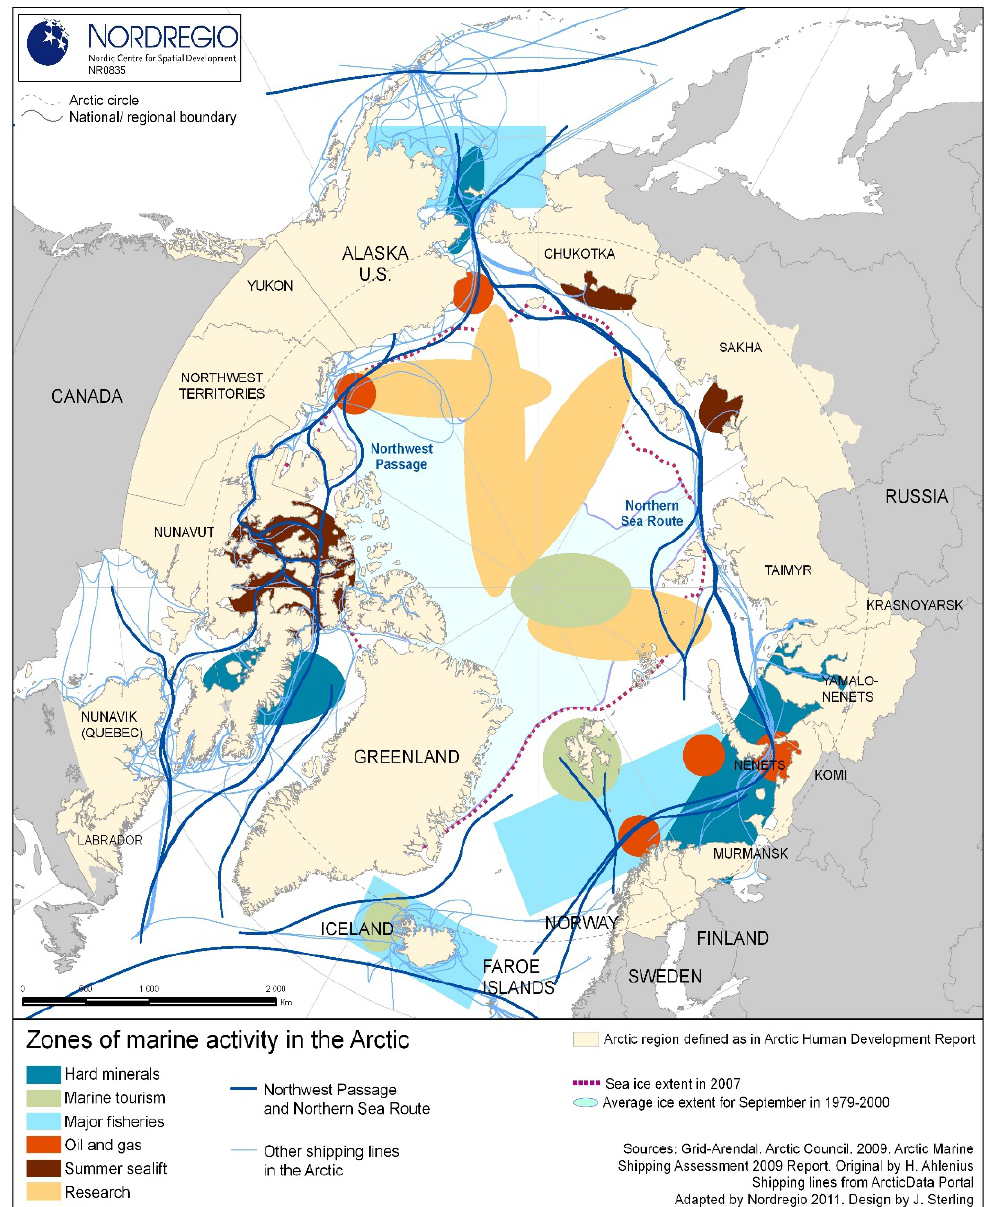
Figure 2. Zones of marine activity in the Arctic. Designer/Cartographer: original by H. Ahlenius, adapted by Jose Sterling. Courtesy of Nordregio [22].